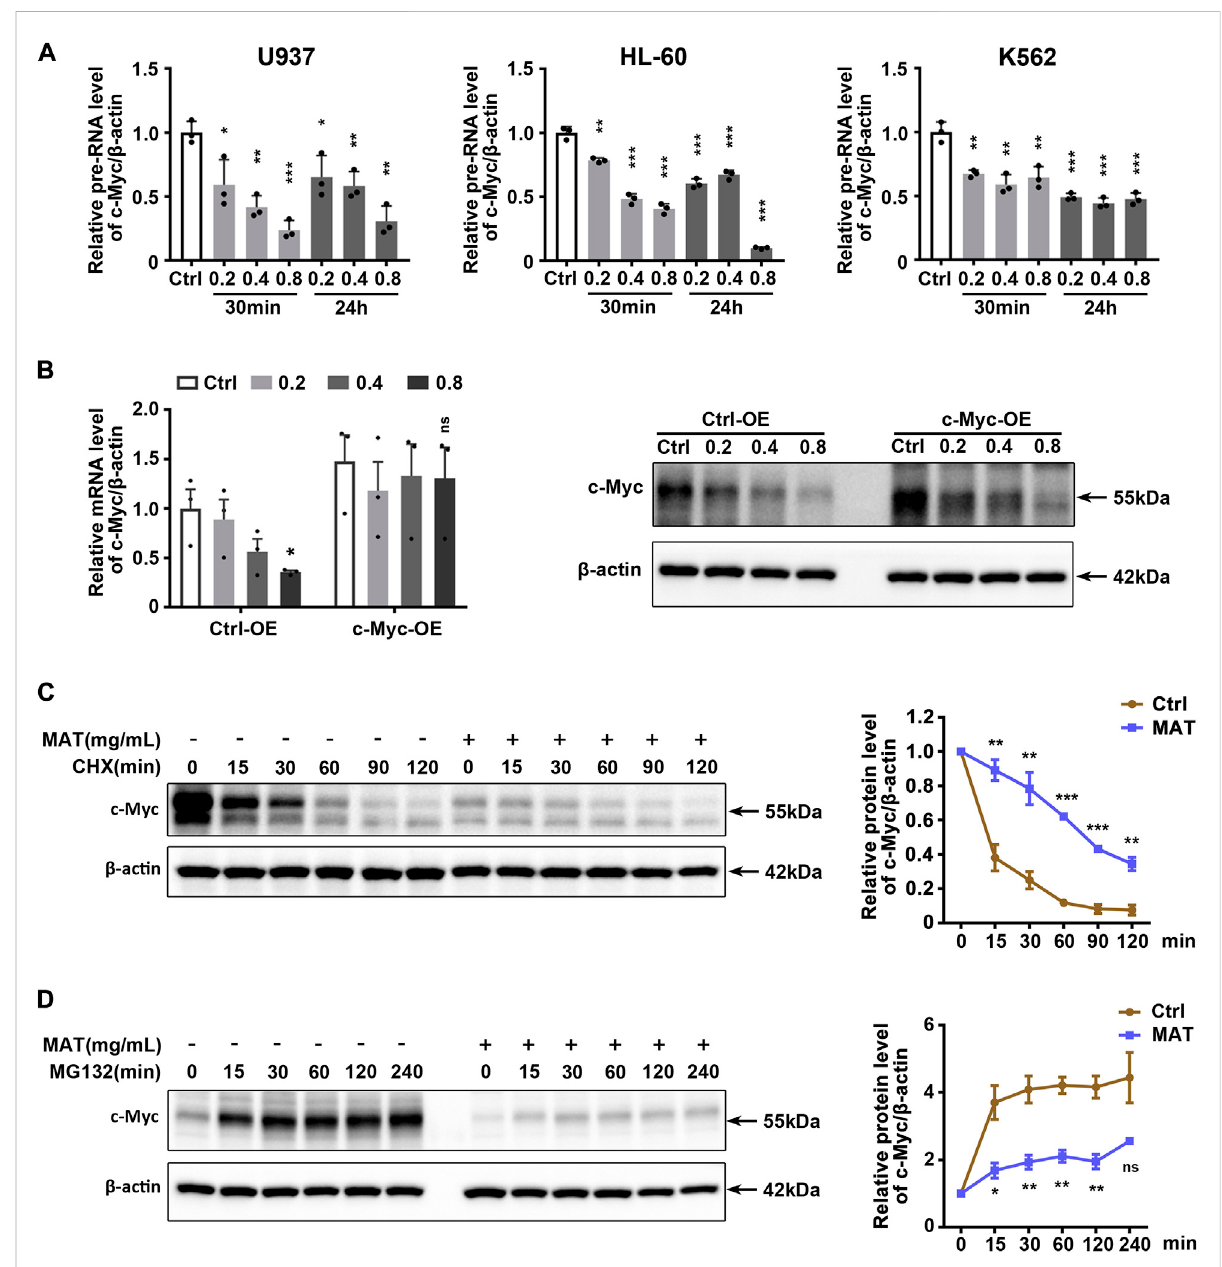
FIGURE 6 Matrine inhibits both transcription and translation of c-Myc. (A) QPCR analysis of pre-RNA level of c-Myc in 3 cell lines treated with 0.2,0.4 and 0.8 mg/ml matrine for 30 min and 24 h, respectively. (B) QPCR and western blotting analysis of c-Myc mRNA and protein level in c-Myc- overexpressing U937 cell line and control group treated with 0.2,0.4 and 0.8 mg/ml matrine for 24 h. (C,D) Time-course analysis of c-Myc protein level in U937 cell line. Cells were treated with 0.8 mg/ml matrine for 22 h (C) or 20 h (D) , then incubated with 50 μ g/ml CHX (C) or 10